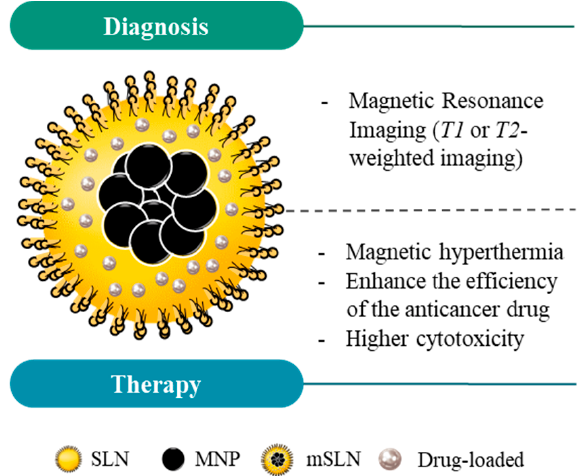
Figure 7. Schematic structure of magnetic solid lipid nanoparticles (mSLNs) and their application in cancer theranostics. Due to the properties of magnetic nanoparticles (MNPs), mSLNs can be used for diagnostic purposes (e.g., MRI application) and cancer therapy via magnetic hyperthermia. Moreover, magnetic hyperthermia in mSLNs offers an extra level of control over the drug release into the region of interest, ultimately increasing the cytotoxicity for cancer cells in comparison with SLNs or MNPs